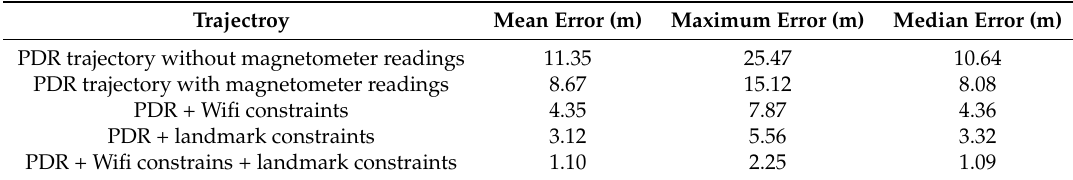
Table 1. Error statics at the test landmarks for different trajectories.